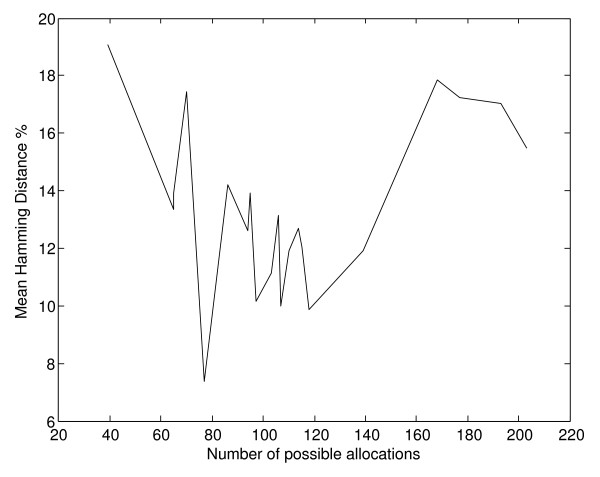
Mean hamming distance, according to number of possible genes to pathways allocations, for module algorithm. There appears to be very small correlation between the mean hamming distance of allocations produced by separate runs of the module search algorithm in terms of percentage and the size of the search space.